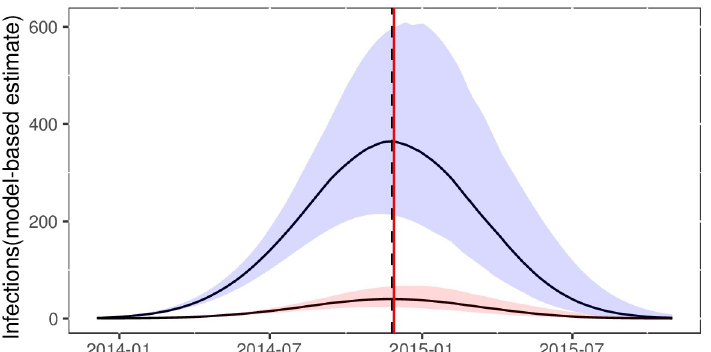
Fig 4. Estimated effective number of infections through time using the superspreading SEIR model for the 2014- 15 Ebola epidemic in Western Africa. The red vertical line shows the time of peak prevalence inferred from WHO case reports. The vertical dashed line shows the model estimated time of peak prevalence. The red trajectory shows the proportion of infections in the high-transmission-rate compartment.